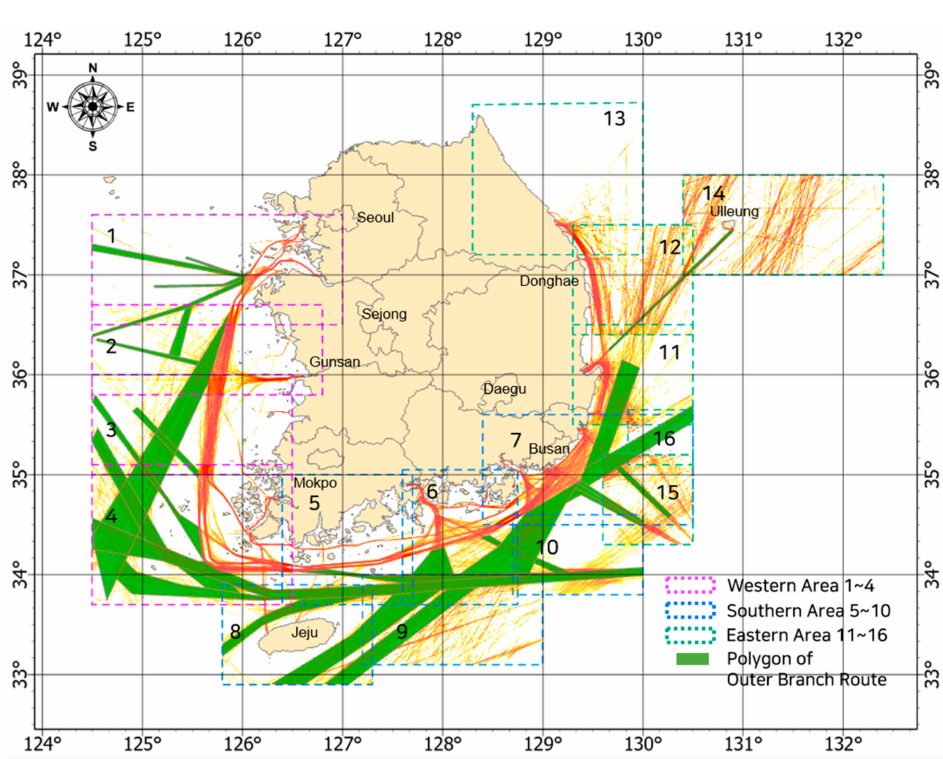
Figure 7. Result of the outer branch route